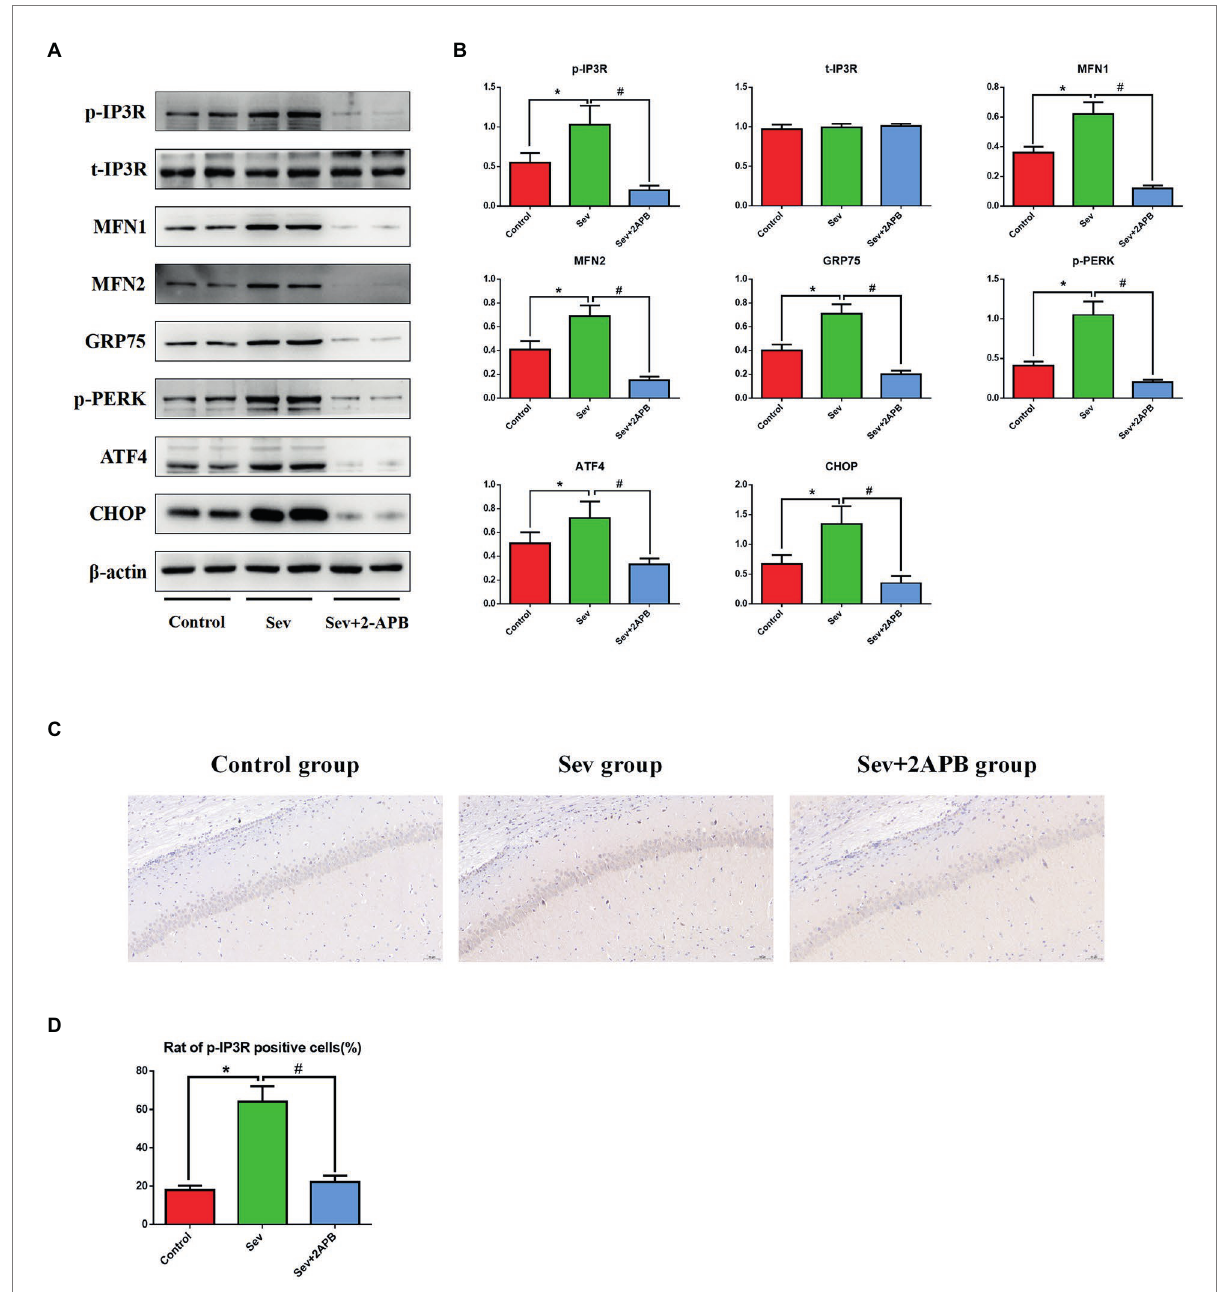
FIGURE 8 Sevoflurane upregulates p-IP3R and activates endoplasmic reticulum stress in aged rats. (A) Representative western blot of p-IP3R, t-IP3R, MFN1, MFN2, GRP75, p-PERK, ATF4 and CHOP. (B) Representative histogram of the relative expression of p-IP3R, t-IP3R, MFN1, MFN2, GRP75, p-PERK, ATF4, and CHOP. (C) Representative images of immunohistochemistry of p-IP3R in CA1 (scale bar = 50 μ M). (D) Representative histogram of positive cell rate of p-IP3R. Data are presented as mean ± SD ( n = 5 in each group). Compared with the Control group, * p < 0.05; compared with the Sev group, # p <